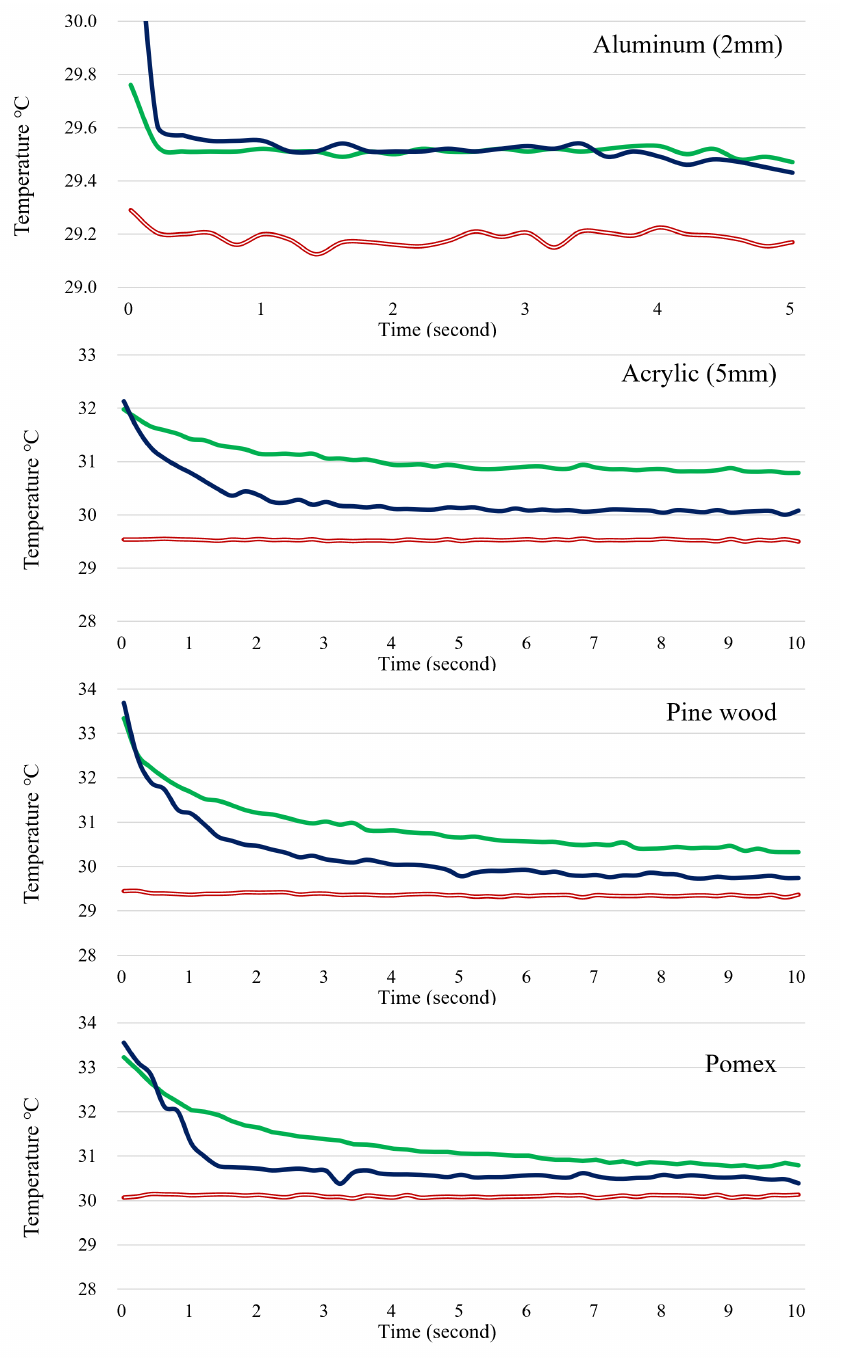
Figure 9. Temperature change over time after hot spot creation. Navy blue line: hollow rod; green line: finger touch; red line: surface of a